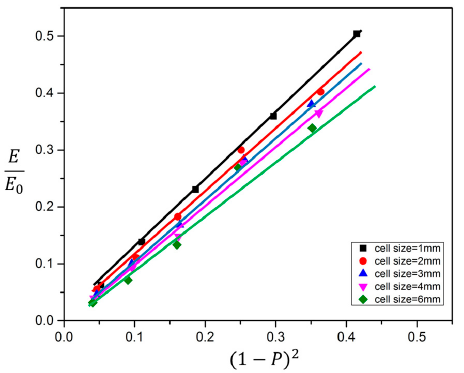
Figure 13. The relative modulus ( E/E 0 ) and the relative density ( ρ / ρ 0 ) of open cellular structures vary with unit cell sizes illustrated in Table 2.